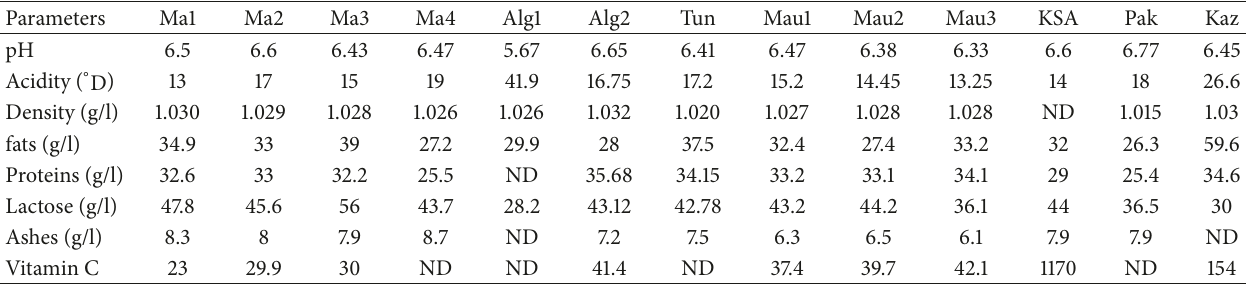
Table 2: Daily recovery (fats, proteins, lactose, and vitamin C) insured by milk of the camel and goat’s and cow’s milk. Milk source Recovery (%) ∗ Chemical elements Camel Goat Cow Camel Goat Cow Fats (g/l) 39 3.02 Proteins (g/l) 32.2 Lactose (g/l)